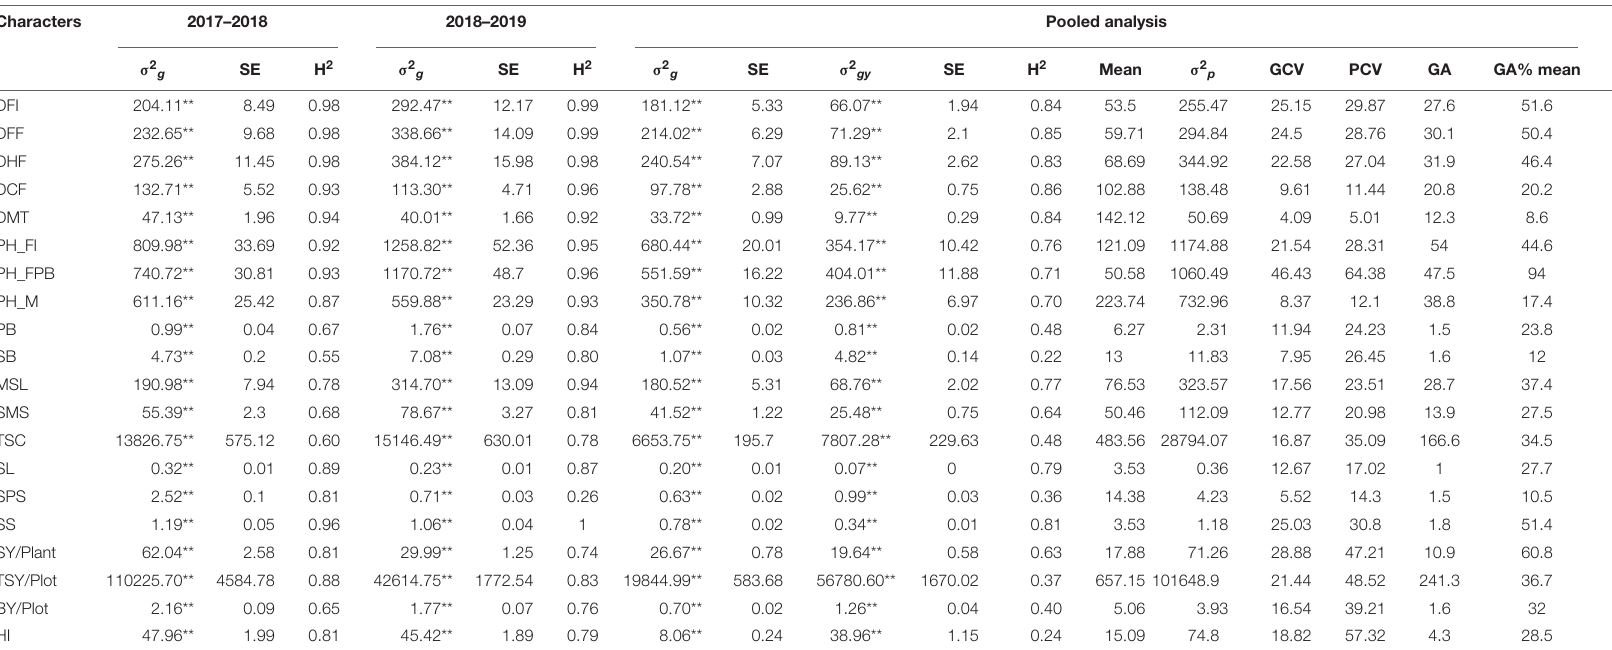
TABLE 2 | Genotypic variance ( σ 2 g ), genotypic–year interaction variance ( σ 2 gy ), standard error (SE), and heritability in broad-sense (H 2 ) estimated over each season and pooled data along with pooled mean values, genetic and phenotypic coefficients of variation (GCV and PCV), genetic advance (GA), and genetic advance as percentage of mean for the 20 traits